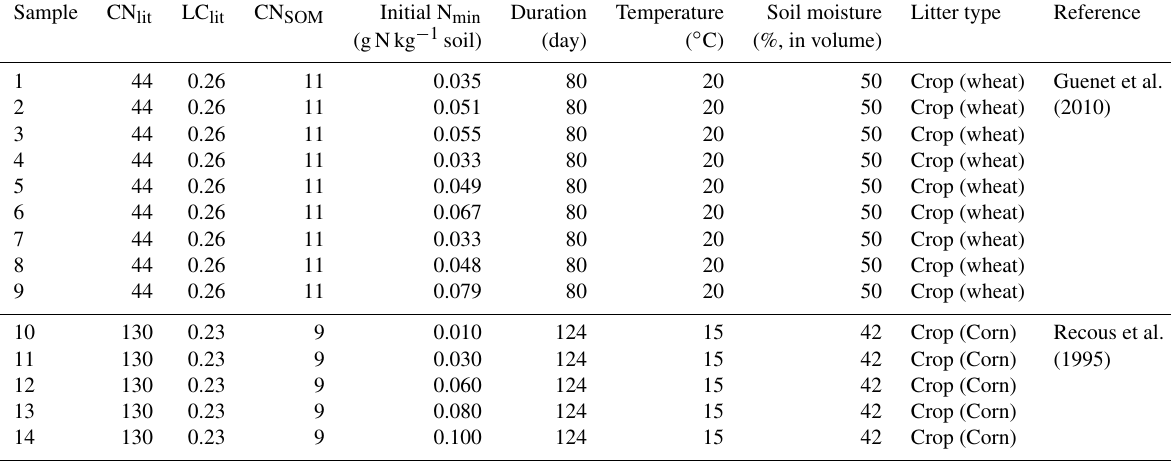
Table A2. Information about the 14 samples of laboratory incubation experiment used in this study. CN lit and LC lit are the C:N ratio and lignin-to-C ratio of plant litter, respectively. CN SOM is the C:N ratio of SOM pool. N min is the concentration of soil mineral N − N). For the incubation experiments of Guenet et al. (2010), cumulative respired litter C was measured on days 1, 3, − N + NH + (NO − 3 4 7, 15, 22, 28, 35, 42, 49, 67 and 80, and N min was measured on days 3, 7, 17, 28 and 80. For the incubation experiments of Recous et al. (1995), both cumulative respired litter C and N min were mostly measured on days 2, 3, 6, 11, 15, 18, 29, 40, 69 and 124.